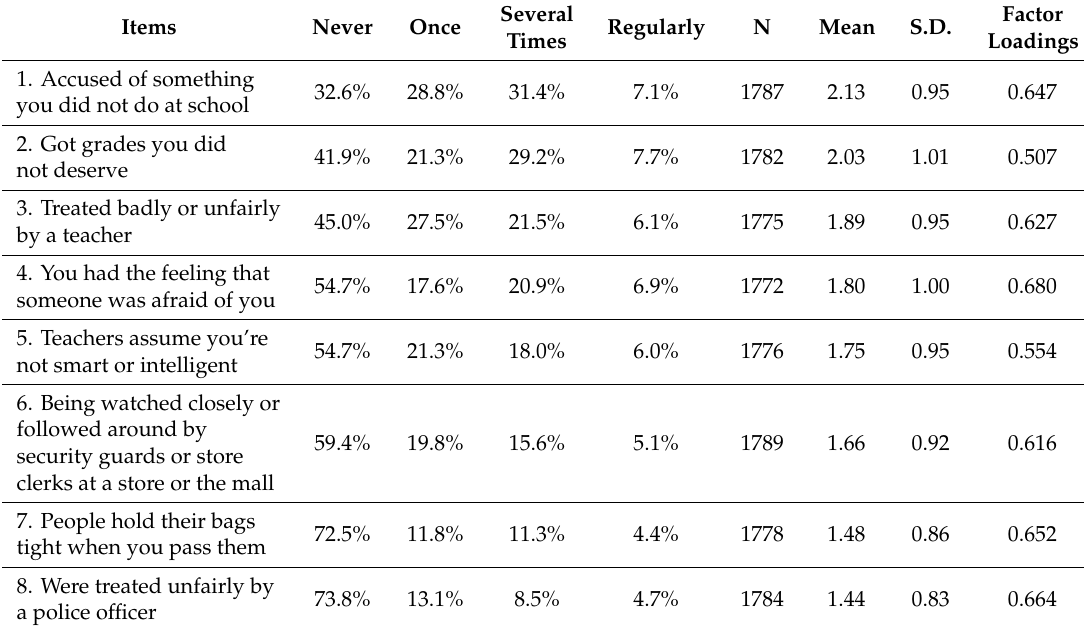
Table 1. Item wordings and descriptors of “perceived